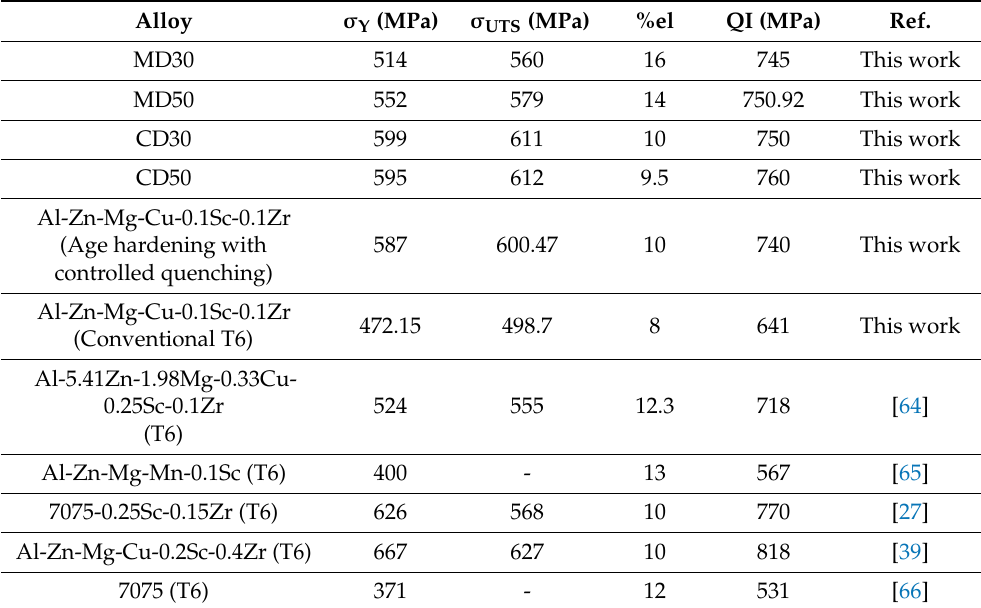
Table 7. Tensile properties of alloys and comparison between the results of the present study with other